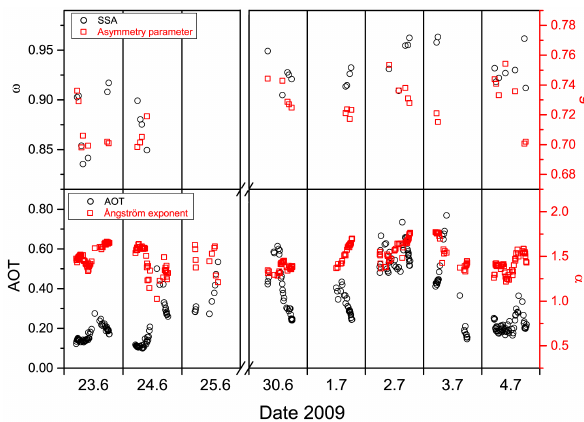
Figure 2. Summary of the AERONET data obtained during the golden days of the CINDI campaign. Top: single scattering albedo ω and asymmetry parameter g at 441nm from almucantar mea- surements. Bottom: AOT at 440nm and Ångström coefficient α re- trieved from direct sunlight measurements at 440 and 675nm.